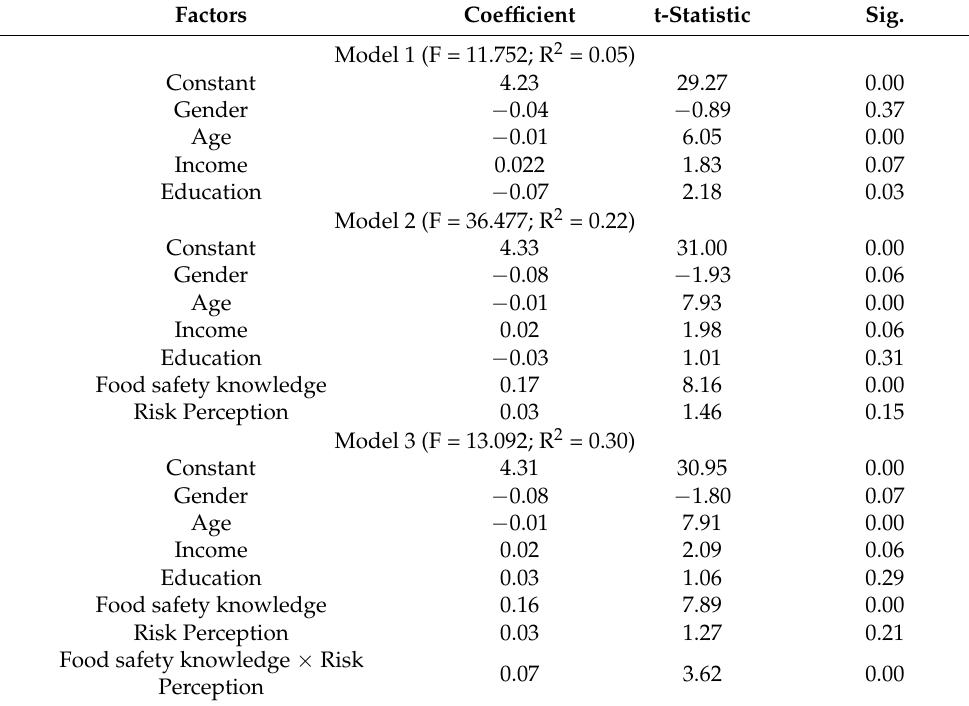
Table 6. Hierarchical multiple regression analysis with all potential